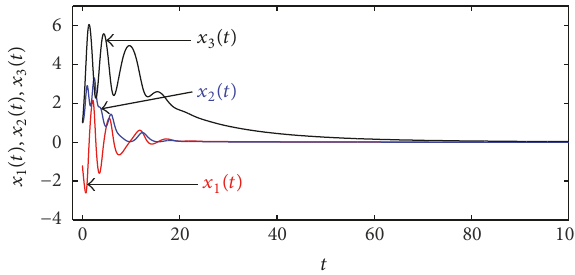
Figure 8: Stabilization of system (7) for 𝑞 = 0.99 and 𝐾 = −4